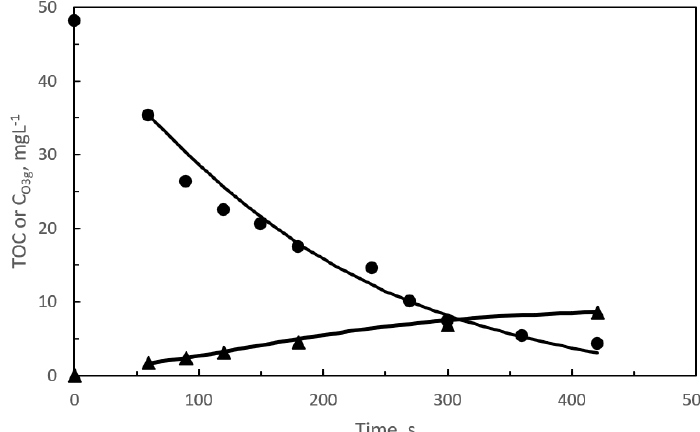
Figure 2. Photocatalytic ozonation: Changes with time of calculated and experimental TOC ( • ), due to pharmaceuticals, and ozone gas concentration at the reactor outlet ( ▲ ) for the first kinetic reaction period. Symbols represent experimental data while curves are calculated data. Experimental conditions: pH = 7.5, gas flow rate: 35 L h − 1 , ozone mass rate: 5.83 mg min − 1 . SEMWW initial TOC: 10 mg L − 1 . Initial TOC due to pharmaceuticals: 46.5 mg L − 1 . Radiation source: VisLED at 425 nm. Incident flux of radiation: 307 W m − 2 . Catalyst: 0.4 g L − 1 of 1.5% GO/TiO 2 .